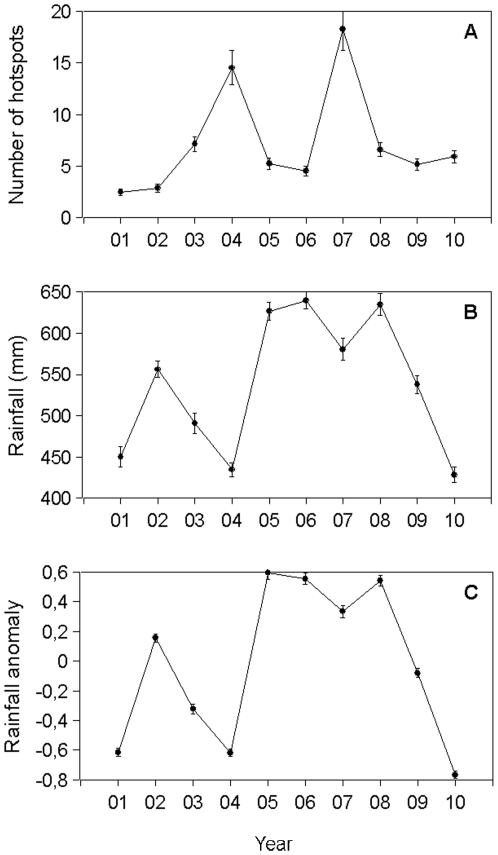
Mean values (±standard error of the mean) of the (a) number of fire hotspots (HP) in the period including December of the previous year and January and February of the current year (DJF); (b) accumulated rainfall in the DJF period (mm); and (c) precipitation anomalies in the DJF period between 2001 and 2010 (without units).